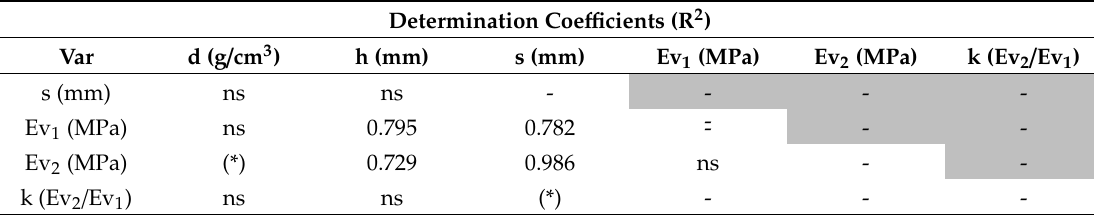
Table 17. Slate random fill in crown significance matrix.